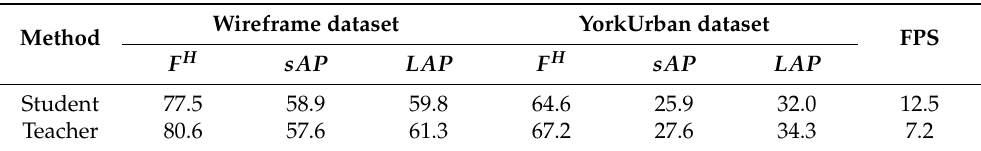
Table 2. Quantitative evaluation of PL-Net point-line detection knowledge distillation method on Wireframe dataset and YorkUrban